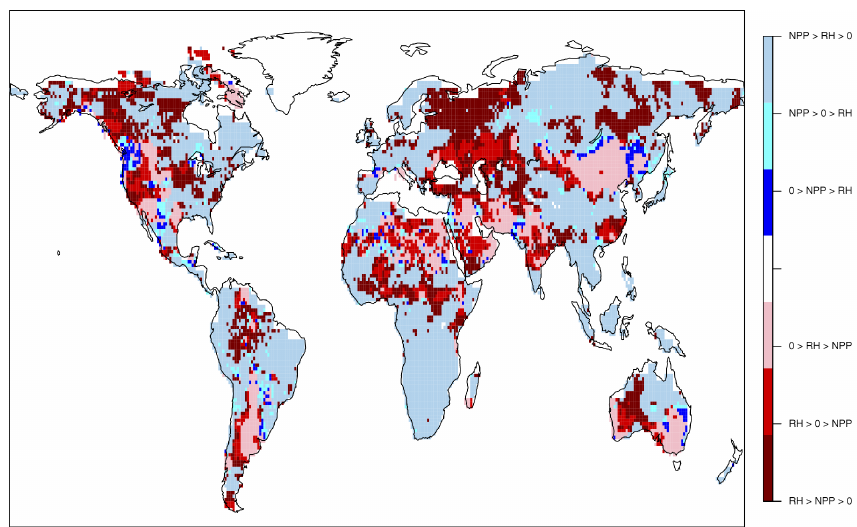
Figure 8. Qualitative change in processes over the period 1990–2009. Negative trend in land–atmosphere net CO 2 flux: enhanced NPP>enhanced RH ( = RH + wildfire + riverine C flux) (pale blue); enhanced NPP, reduced RH (turquoise); and reduced NPP <reduced RH (dark blue). Positive trend in land–atmosphere net CO 2 flux: enhanced NPP<enhanced RH (dark red); reduced NPP, enhanced RH (red); and reduced NPP>reduced RH (pink).